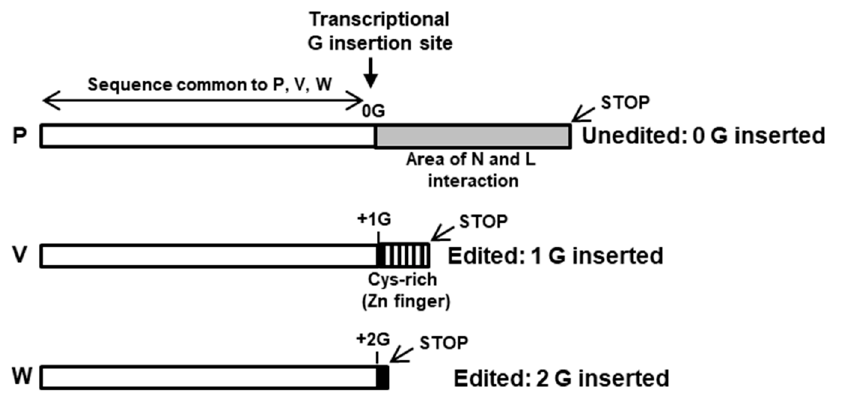
Figure 3. Co-transcriptional mRNA editing in Paramyxoviridae to generate multiple proteins from the P gene. A consensus schematic, modeled after Kato et al. [101], shows insertions of G nucleotides in the mRNA as well as the corresponding protein sequences and their relevant regions (boxed). Whereas the faithful copy of the gene (i.e., no G insertion, or 0G) produces the mRNA that translates into the longest protein, the phosphoprotein P; those with insertions of 1G or 2G generate V and W proteins, respectively. Due to the translational frameshift, the amino acid sequences of V and W diverge downstream of the G insertion, while all three proteins have identical sequences upstream (white box). The divergent sequence at the C-terminus encodes binding sites for viral proteins, N and L (in P, grey color), a Cys and Pro-rich zinc finger domain (in V, vertical stripes), and the shortest protein (W) with the common sequence only (since the W reading frame generates a translational stop codon soon after the 2G insertion). The positions and lengths are not drawn to